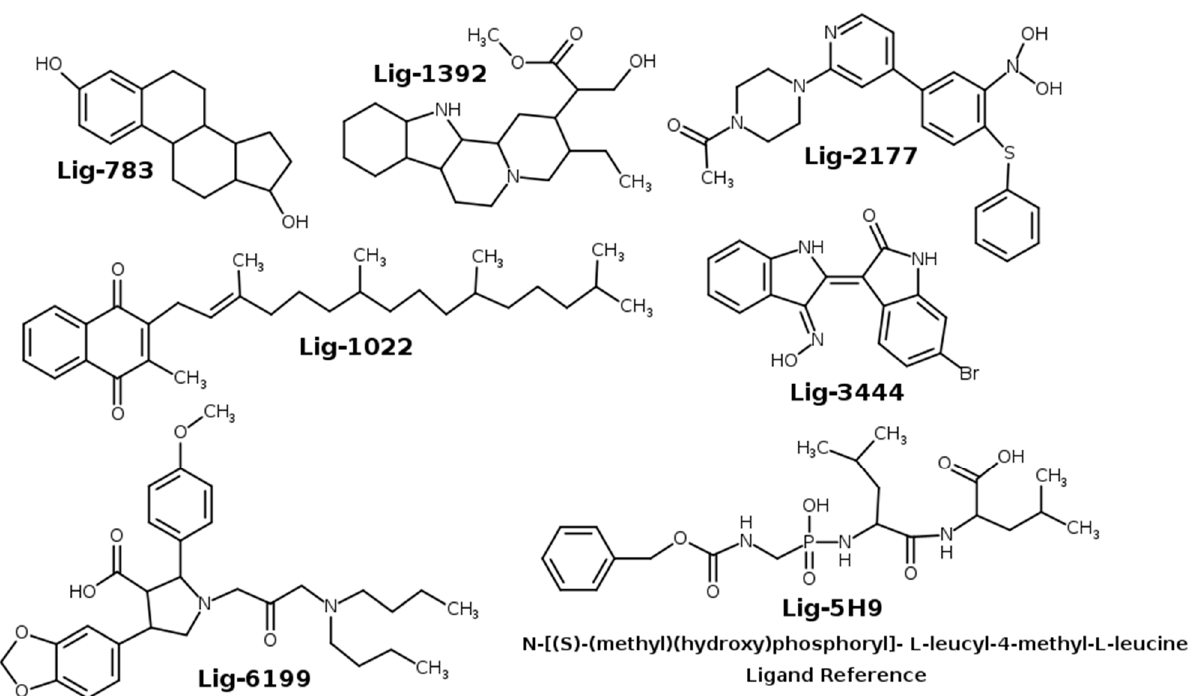
Figure 1. Molecular structure of thermolysin inhibitors evaluated as possible antibacterial agents.